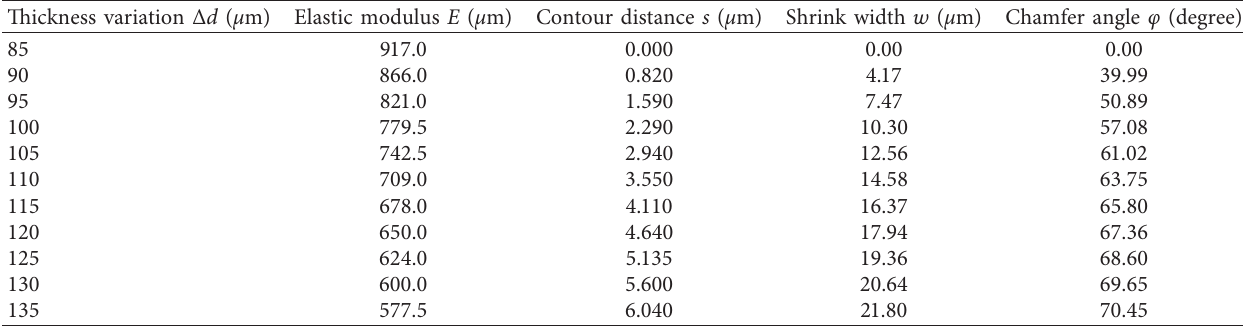
Table 4: Parameter setting used in Groups A-D.